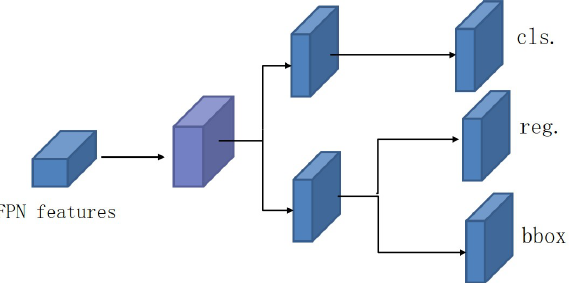
Figure 4. The schematic diagram of decoupling head. The detection head is divided into three different branches that perform classification, regression, and bounding-box prediction,